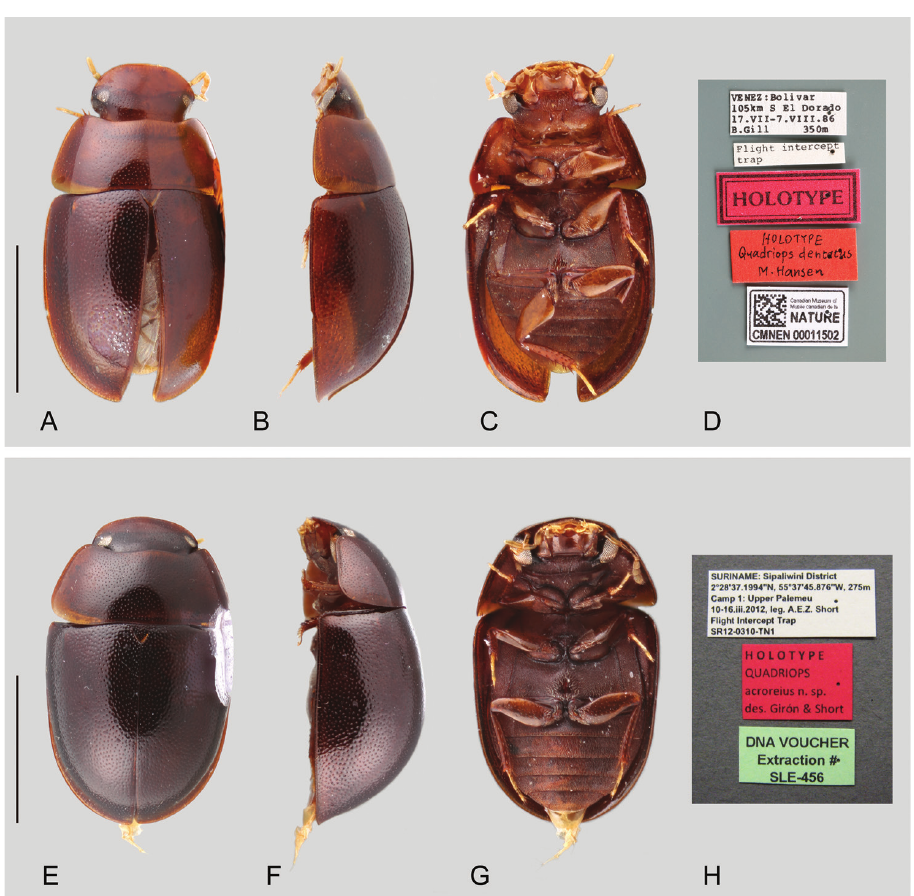
Figure 1. Habitus and labels of Quadriops spp.: Q. dentatus (holotype): A dorsal view B lateral view C ventral view D labels; Q. acroreius sp. n. (holotype): E dorsal view F lateral view G ventral view H la- bels. Scale bar 1